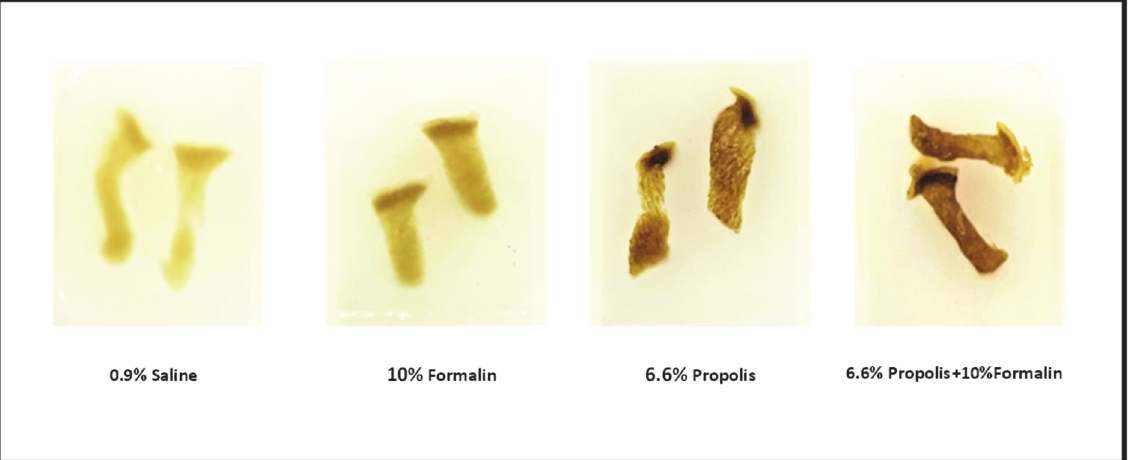
Figure 5. Paraffin wax-embedded blocks showing dark brown discoloration in tissues placed in 6.6% propolis compared with those placed in other solutions.